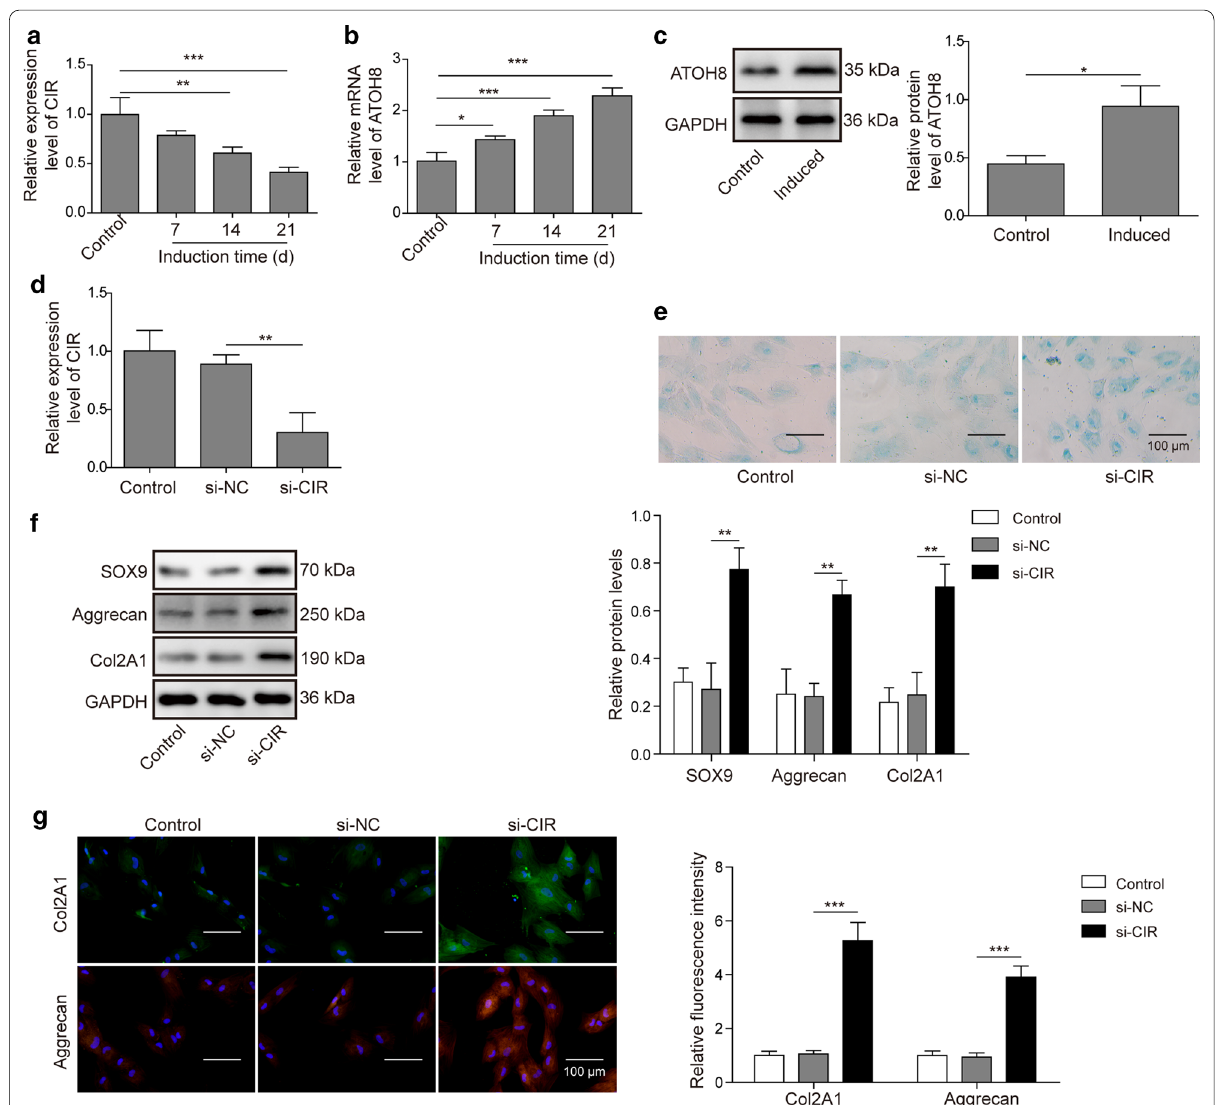
Fig. 2 LncRNA CIR knockdown promotes chondrogenic differentiation of hUC‑MSCs. a qRT‑PCR analysis of lncRNA CIR level in control and differentiated hUC‑MSCs. b qRT‑PCR analysis of ATOH8 mRNA level in control and differentiated hUC‑MSCs. c Western blot analysis of ATOH8 protein